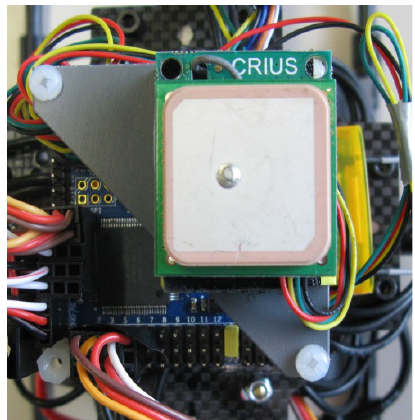
Figure 1. Single frequency receiver u-blox NEO-6M with